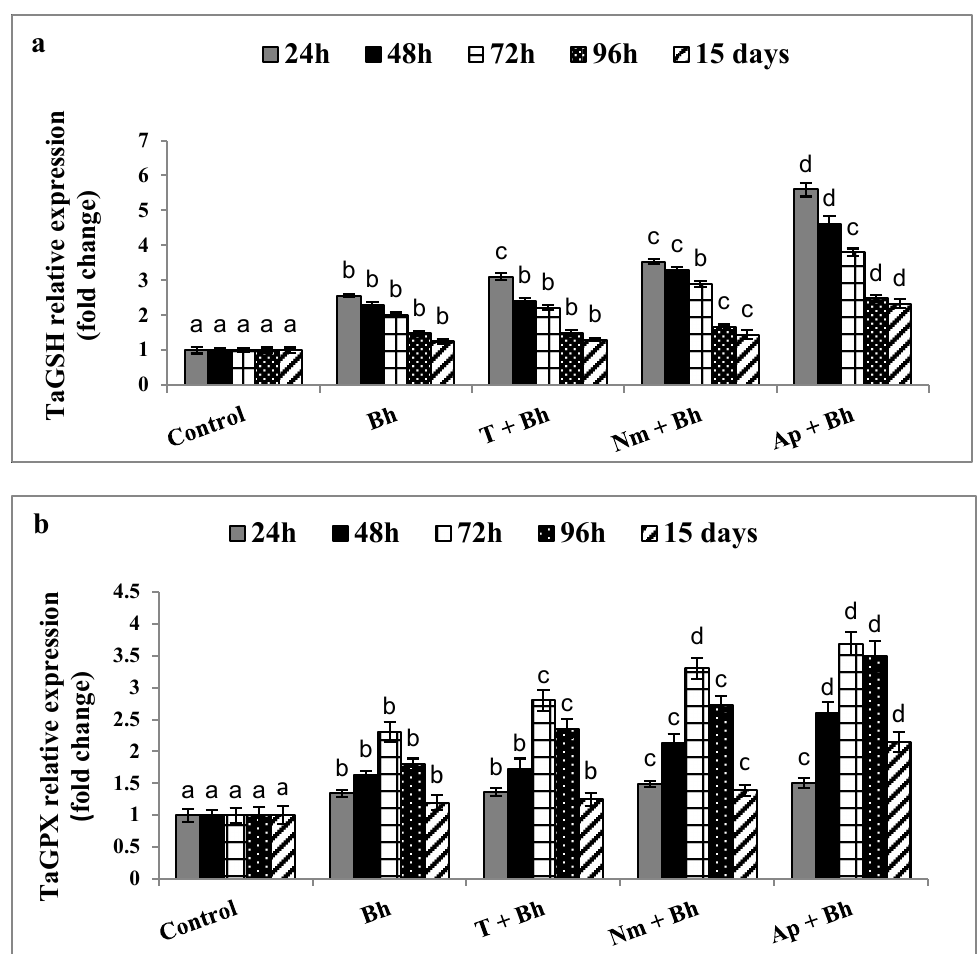
Figure 3. Relative expression of wheat antioxidant-related genes, ( a ) TaGSH and ( b ) TaGPX , after treatment with bromoxynil alone and or in combination with different safener treatments. The GABDH gene was used as the housekeeping gene. Data are presented as the mean ± SD ( n = 3). Bh: bromoxynil; T + Bh: tryptophan + bromoxynil; Nm + Bh: Nostoc muscorum + bromoxynil; Ap + Bh: Arthrospia platensis + bromoxynil. Different letters on the bars indicated a significant difference between treatments at p < 0.05.